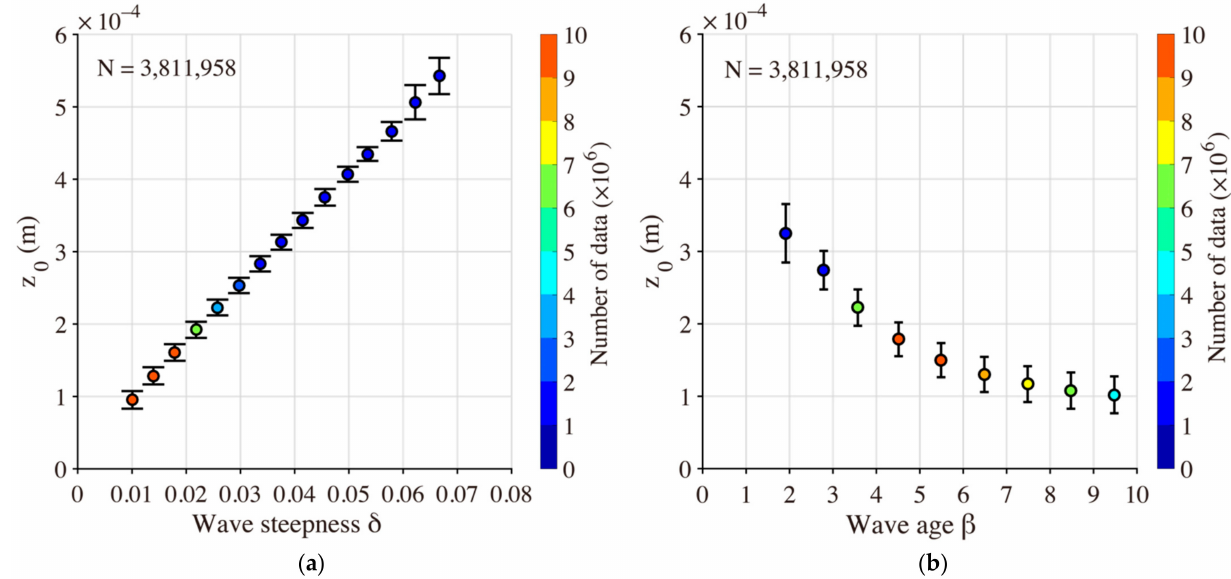
Figure 4. ( a ) The relation between sea roughness z 0 and wave steepness δ for a 0.004 bin. ( b ) The relation between sea roughness z 0 and wave age β for a 0.1